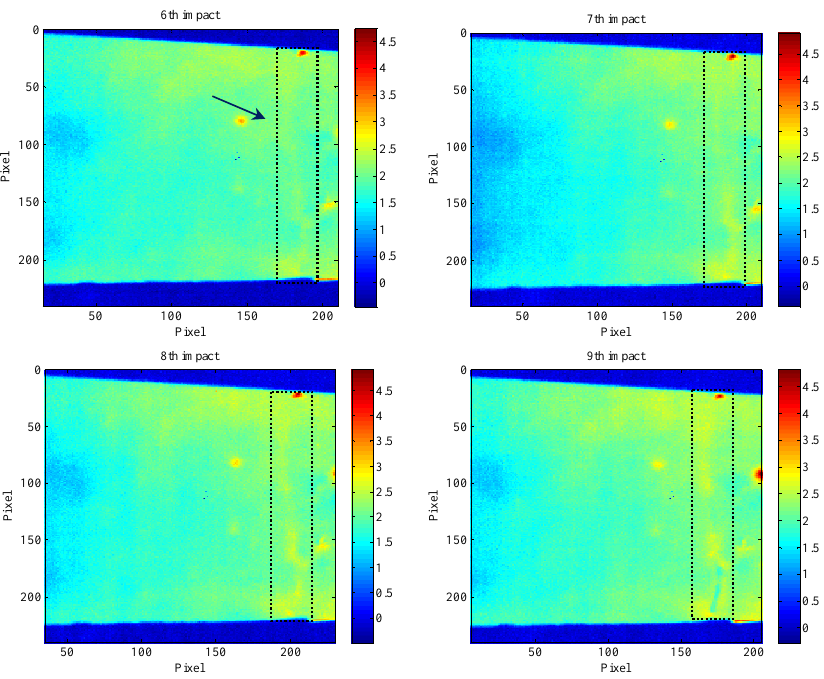
Figure 5. Thermal contrast of last four impacts in the warm ‐ up period (The rectangular box indicates the elongated abnormal zone corresponding to the cracks).